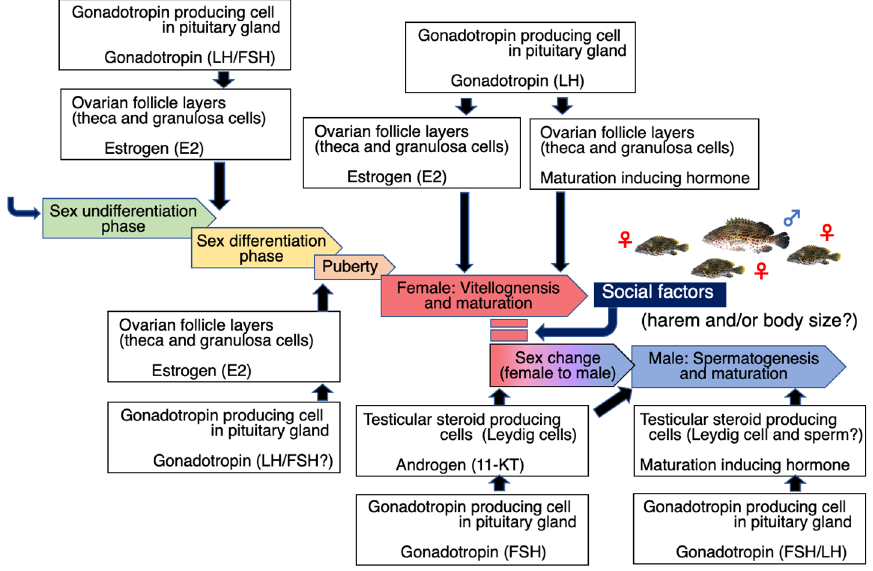
Figure 1. Gonadal development in groupers and the endocrine factors affecting these maturation